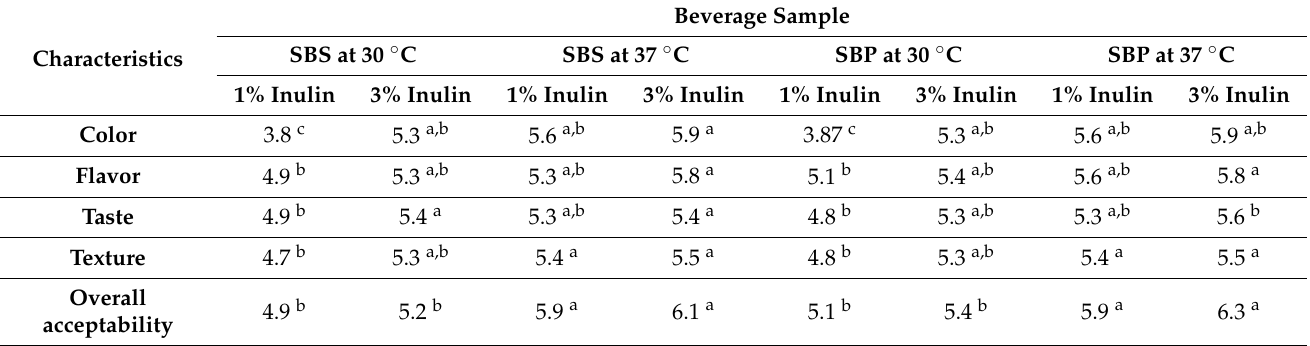
Table 3. Sensory evaluation parameters.